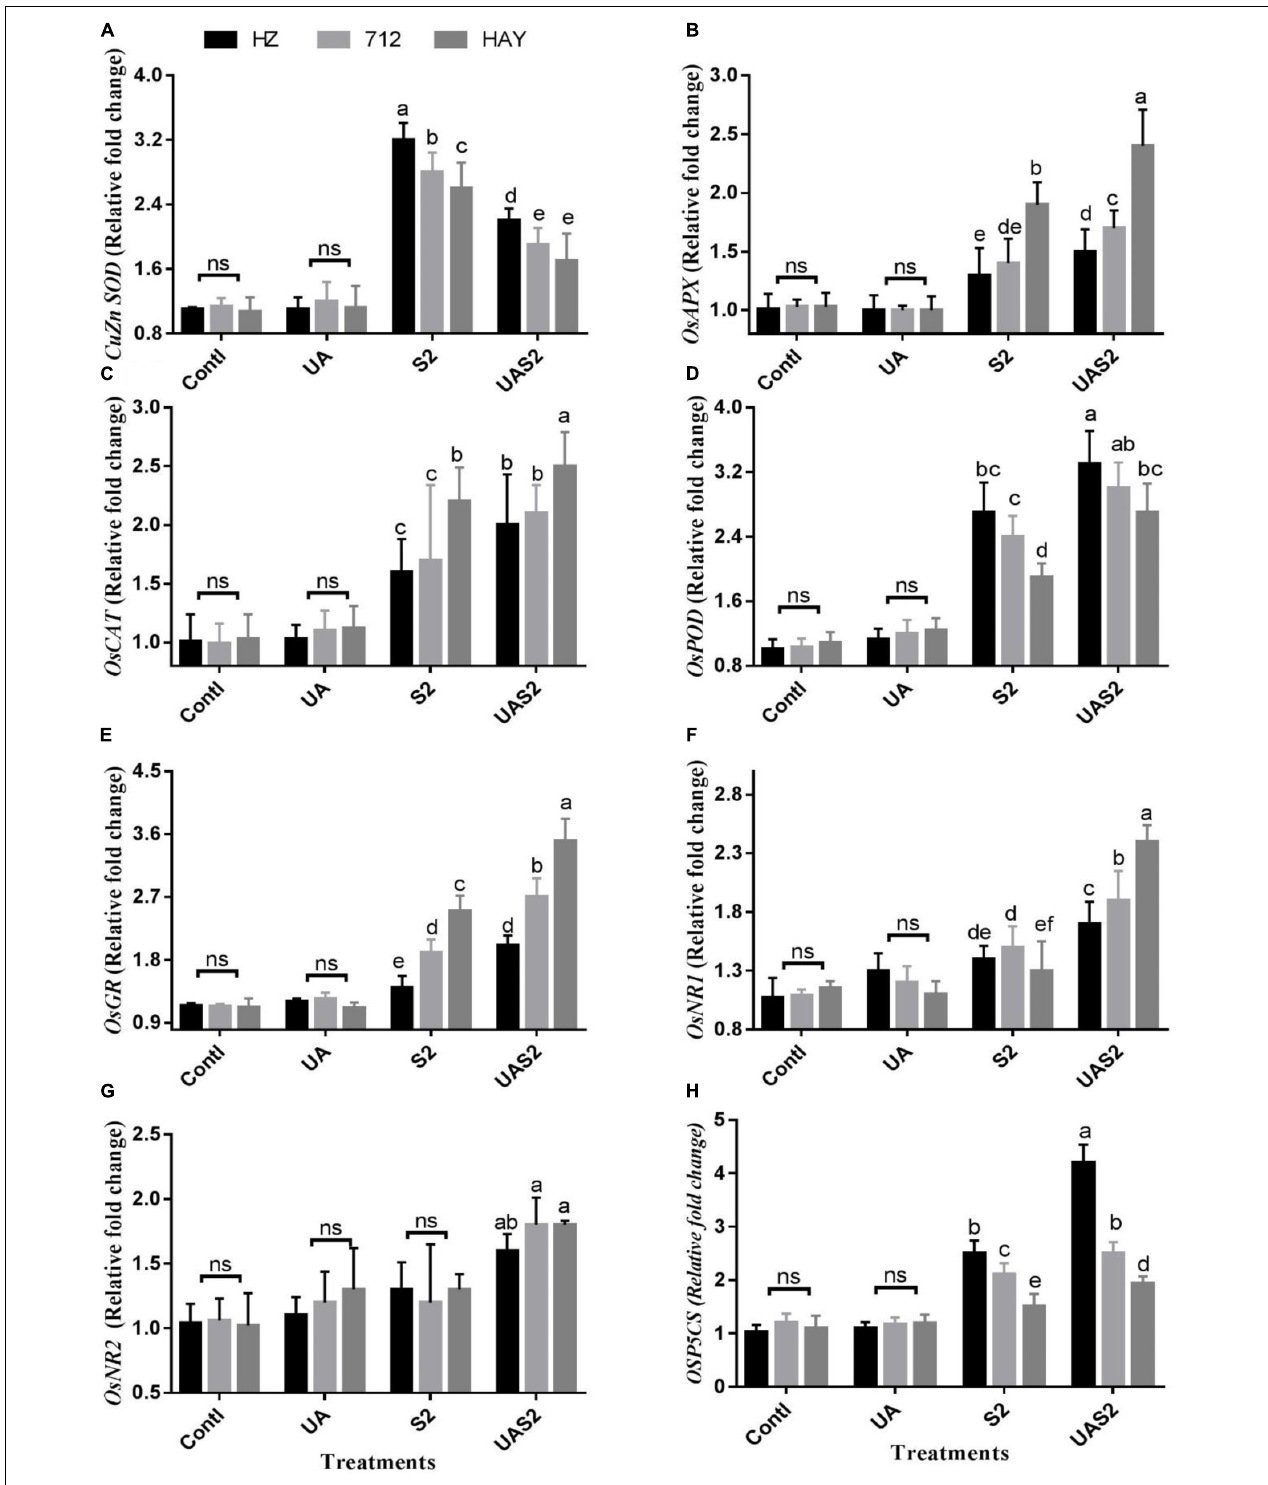
FIGURE 3 | Effect of ursolic acid (UA) on expression of ROS scavenging genes (A–H) in leaves of three rice cultivars under controlled and salt stress conditions. Transcript levels were determined by qRT-PCR and calculated by 2 − (cid:49) (cid:49) CT using ubiquitin as an endogenous reference and control plant as a calibrator. Means with the same letters are not significantly different at p ≤ 0.05 as determined by Duncan’s test. The results show the mean ± SE of four replicates, and three plants were bulked for each replicate. Contl = Control, UA = ursolic acid. S2 = 8 dS m − 1 , UAS2 = ursolic acid + 8 dS m − 1 .